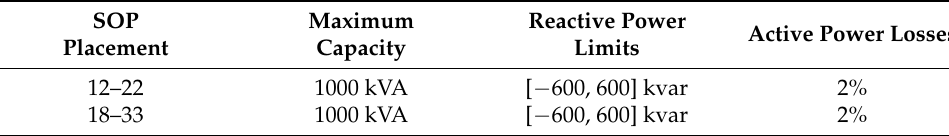
Table 2. Basic installation parameters of the SOP .